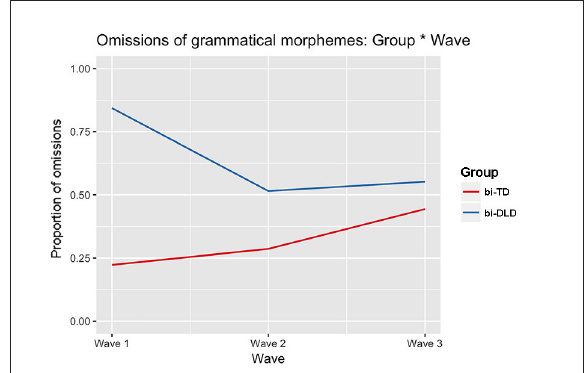
FIGURE4 Interaction effect between Group and Wave on the omission of grammatical morphemes in Dutch.